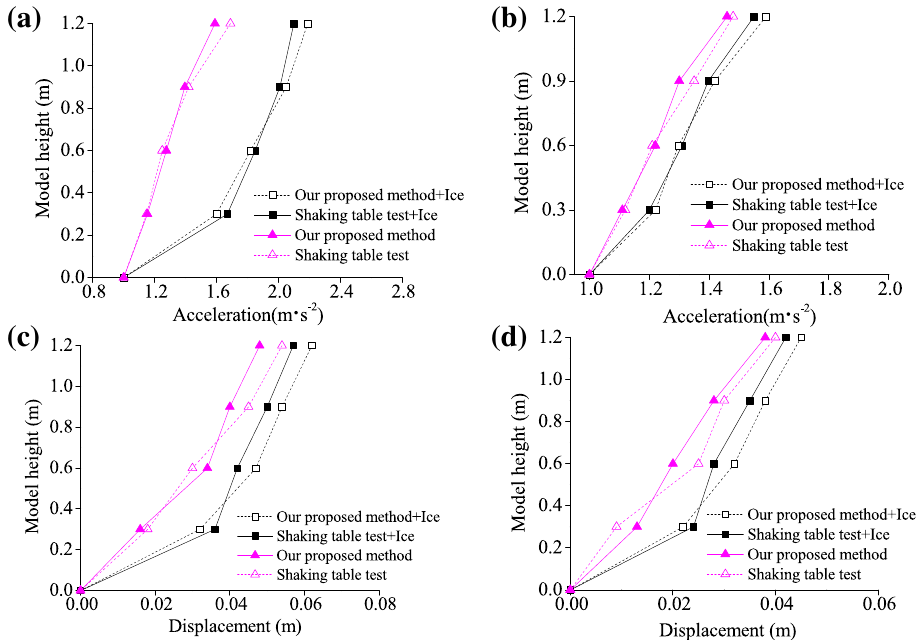
Figure 13. Peak accelerations and displacements along height direction of the model in the presence and absence of influences of sea ice: ( a ) T1-II-1 (acceleration); ( b ) T2-II-1(acceleration); ( c ) T1-II-1 (displacement); ( d ) T2-II-1